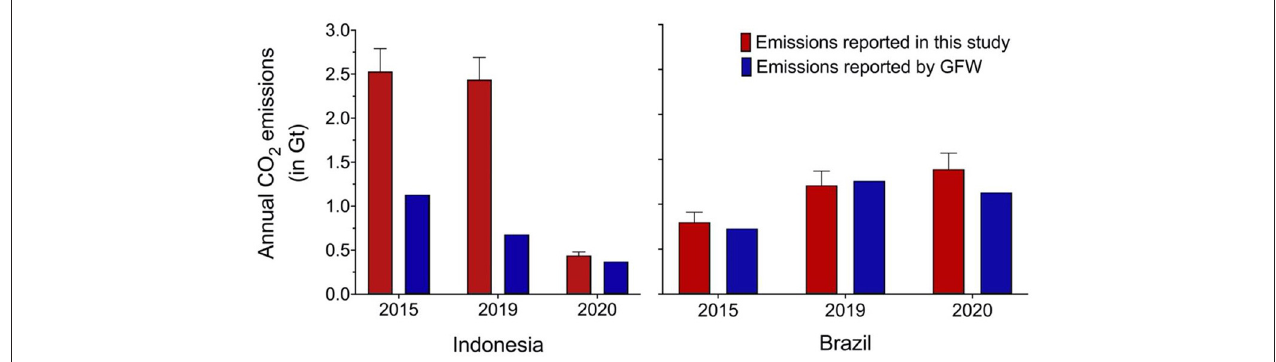
FIGURE 3 | Comparison of the results of this study and the annual emissions reported by Global Forest Watch for 2015, 2019, and 2020 in Indonesia. The results of this study consist of peat soil emissions, dry matter emissions, and aboveground biomass (AGB) emissions and the uncertainties associated with each of these components yields the cumulative error bar presented for each year in the figure. The uncertainties are reported in Table 2 and Supplementary Material .